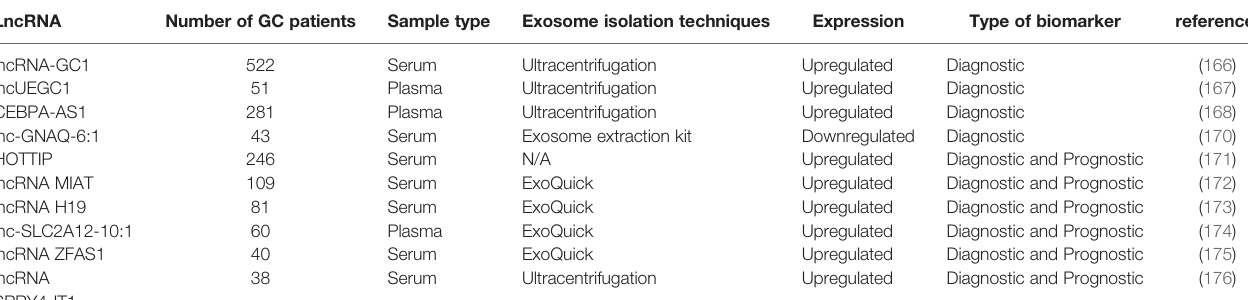
TABLE 3 | The potential biomarker of exosomal lncRNA in